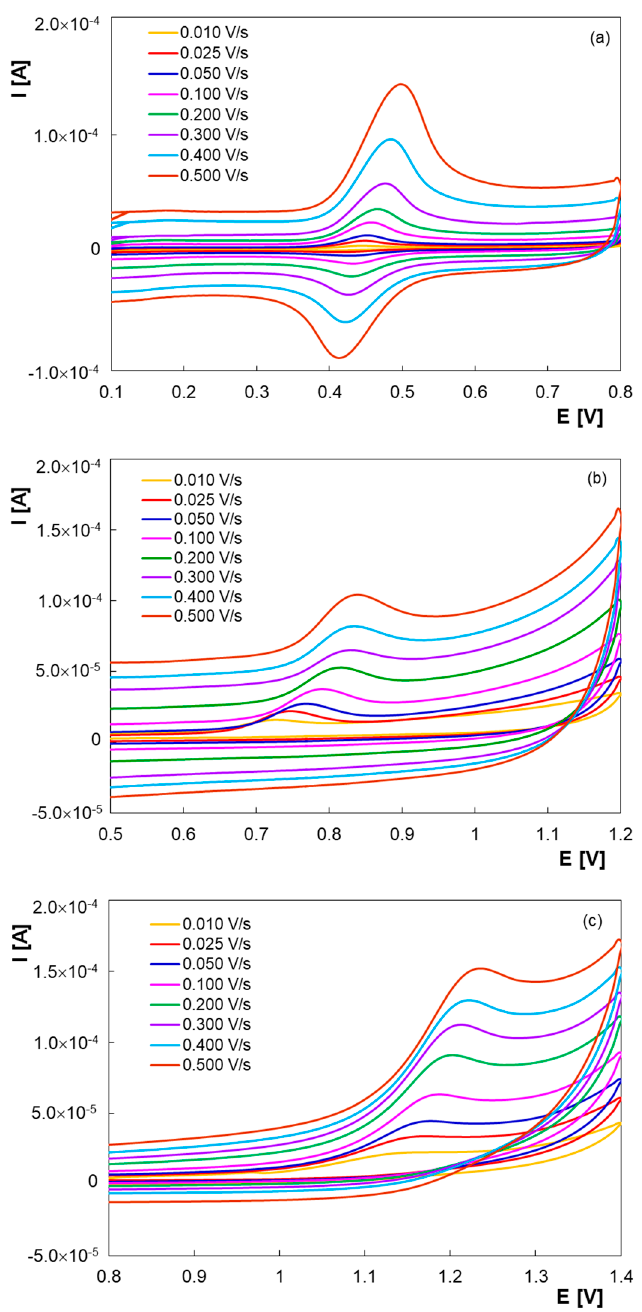
Figure 3. Cyclic voltammograms of 1.00 × 10 − 4 M PAR ( a ), 1.00 × 10 − 4 M PHE ( b ) and 1.00 × 10 − 4 M GFS ( c ) in BR buffer solutions pH 6.00 at PGE* at different scan rate values.